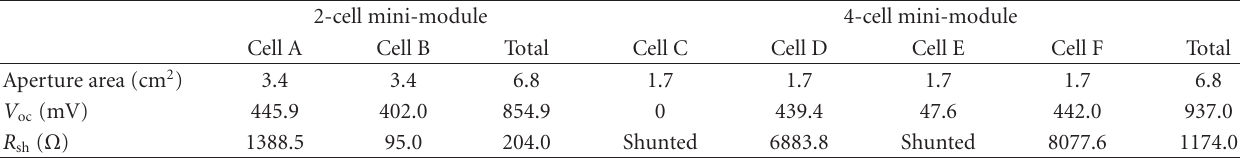
Table 2: Suns- V oc results of the aligned bifacial interconnected metallisation when MgF 2 is used as an insulation layer.